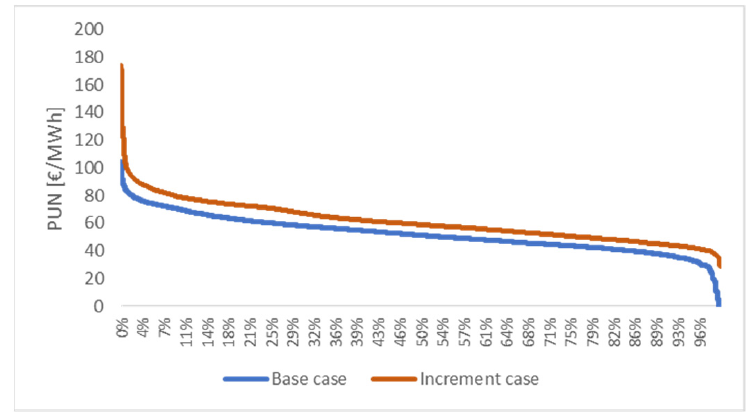
Figure 4. PUN duration curve of Plexos base case and increment case.